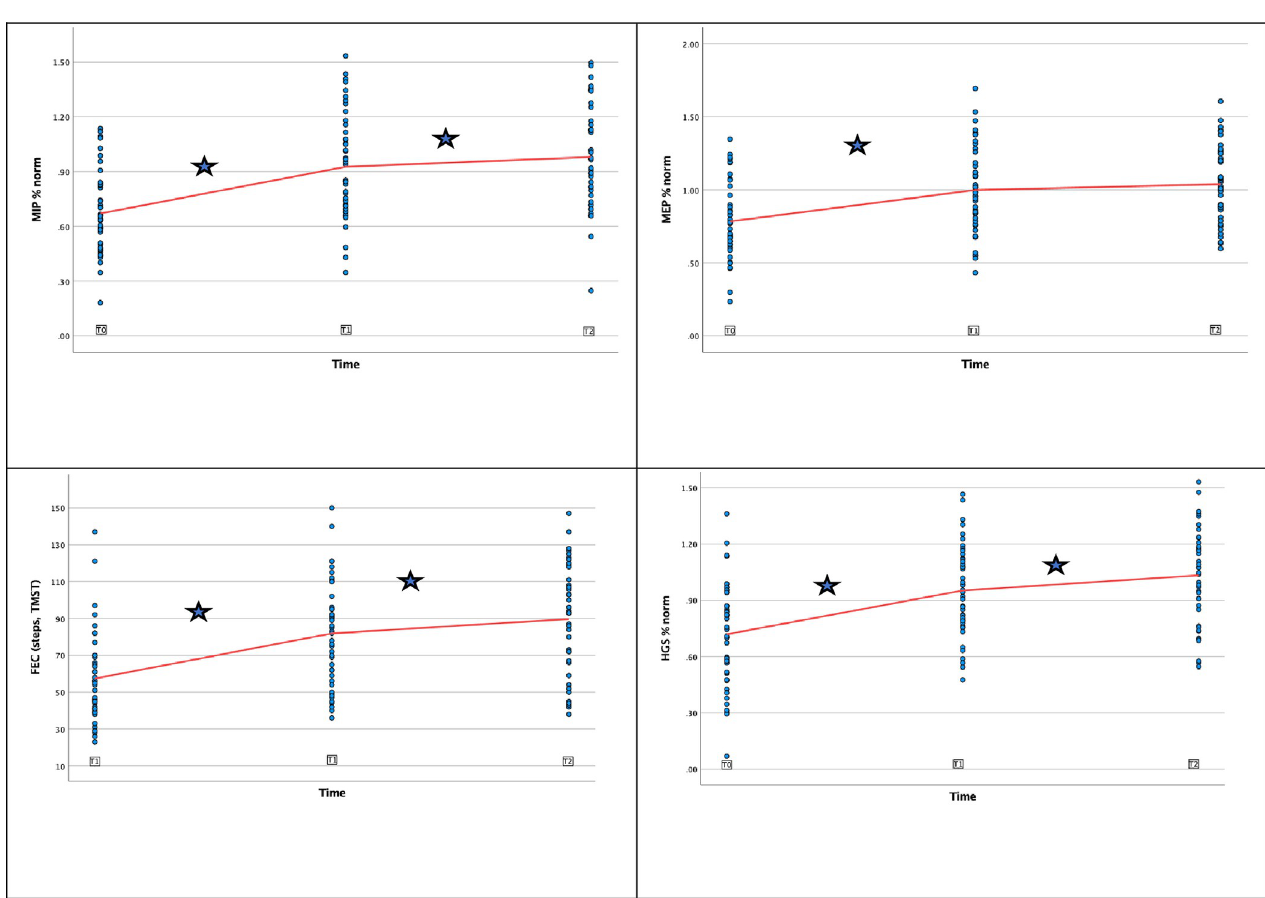
Fig 2. Longitudinal changes in functional outcomes: 2a. MIP, 2b. MEP, 2c. FEC, 2d. HGS. Regression coefficients (red line) plotted against observed data (blue dots) at T0, T1 and T2. $ indicates significant change in regression coefficients between timepoints. Abbreviations: MIP: maximum inspiratory pressure, MEP: maximum expiratory pressure, HGS: Handgrip Strength, FEC: Functional Exercise Capacity, TMST: Two-minute Step Test.